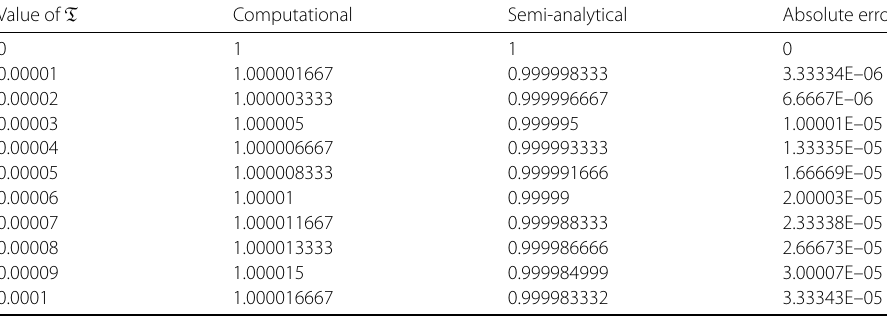
Table 2 Numerical values of the solutions through the EK method Value of T Computational Semi-analytical Absolute error 0